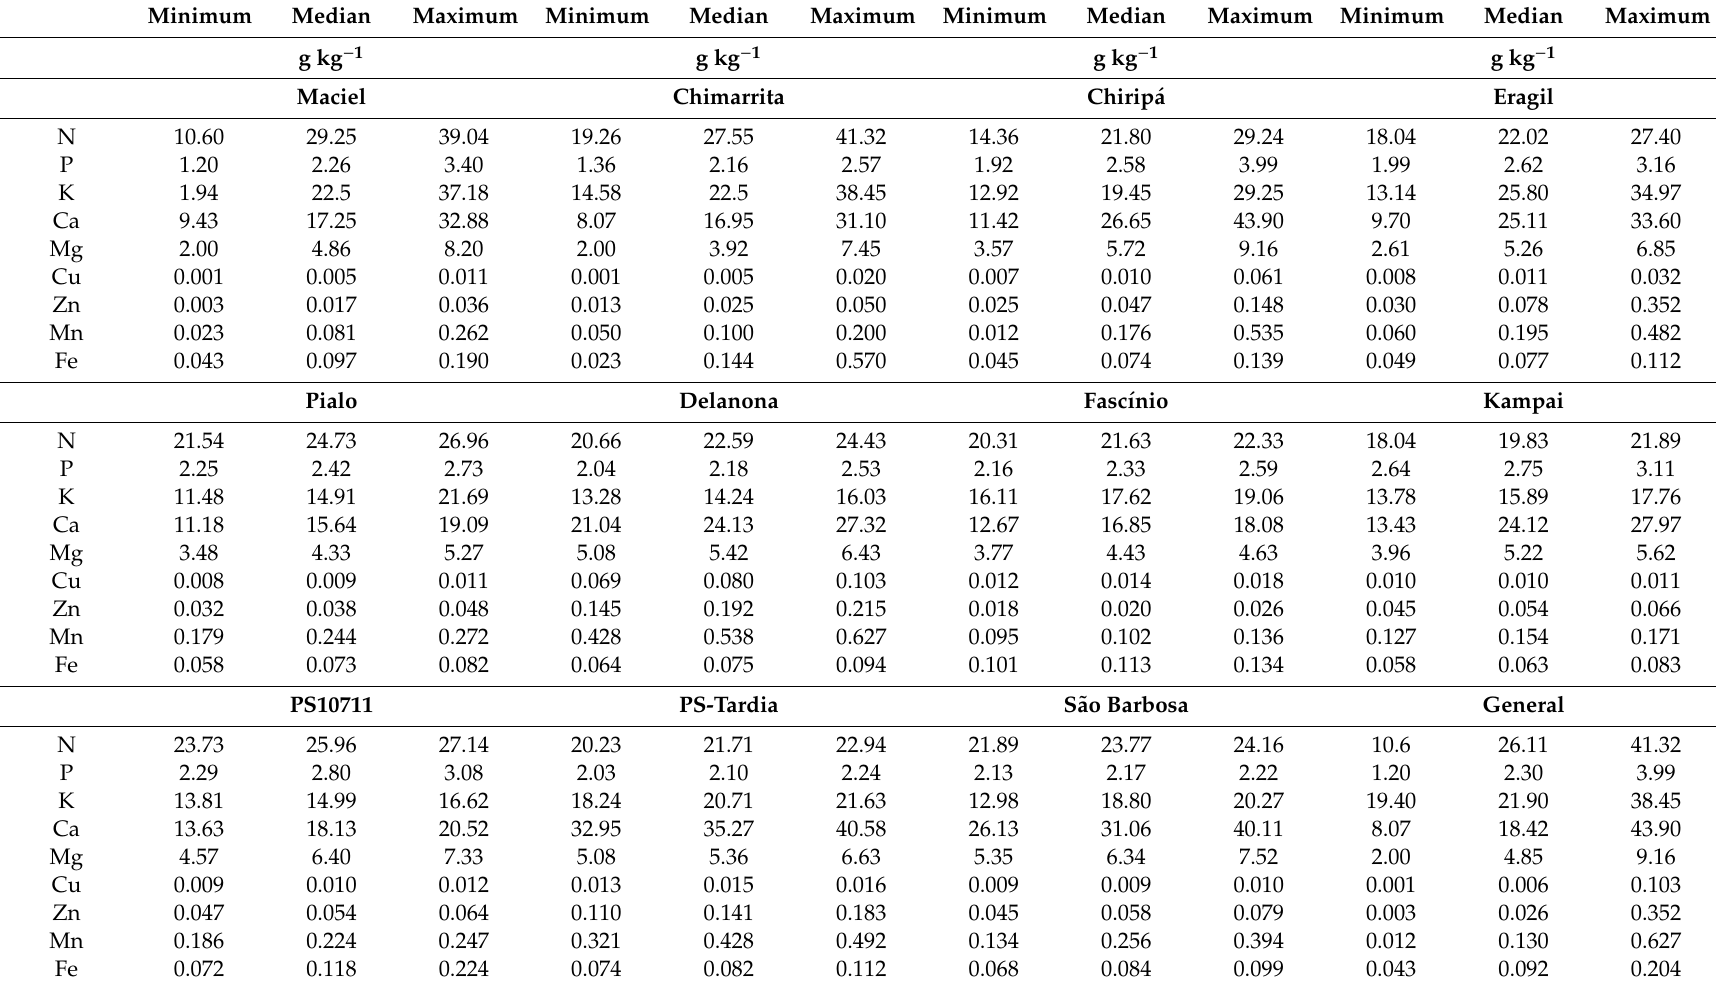
Table 4. Tissue nutrient concentrations of eleven peach cultivars in the peach orchard data set of Rio Grande do Sul.